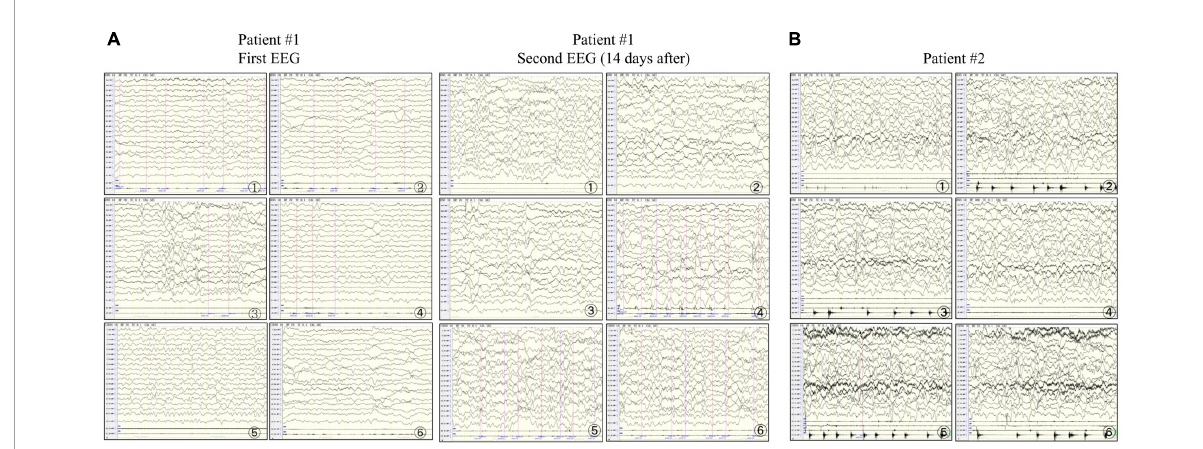
FIGURE2 Electroencephalograms of patients #1 and #2. (A) In patient #1, the first examination shows abundant δ -wave activity in the left and midline regions of the brain. The sharp waves in each area (significant on the left) are synchronized or not synchronized with a few more sharp waves. The second examination shows a slowed background rhythm and more δ -wave activities in the right and midline regions of the brain. The frontal, central, parietal, occipital, and temporal areas (significant on the right) and the midline show numerous sharp slow waves, consistent with epilepsia partialis continua (EPC). (B) In patient #2, the right upper limb twitches rhythmically 1–2 times/s. The electroencephalogram synchronizes with the low to medium amplitude spike wave rhythm in the parietal, occipital, middle, and posterior temporal regions (significant on the right) in the background of diffuse rhythm, which can affect the central region, and the twitches are synchronized with spike waves, consistent with